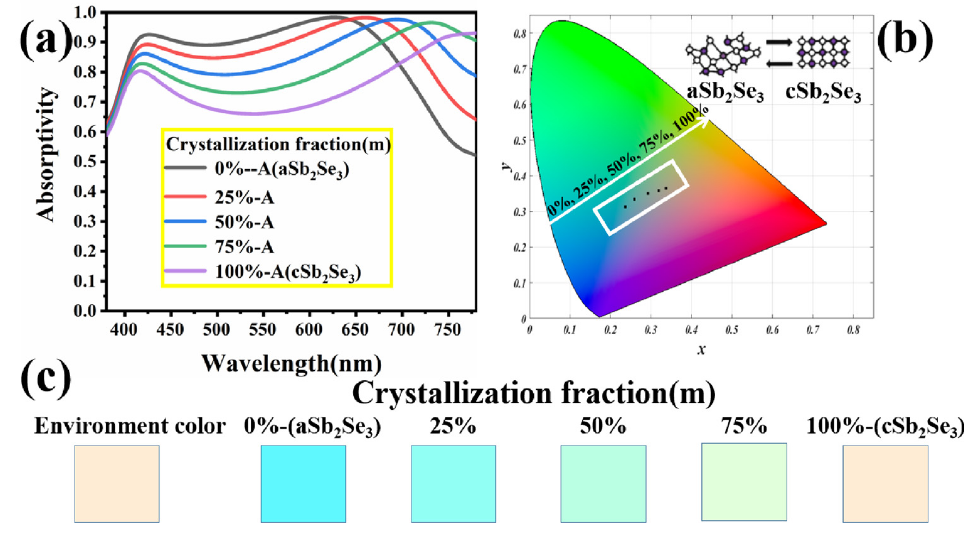
Figure 5. ( a ) Absorption spectra of different Sb 2 Se 3 crystalline fractions; ( b ) coordinates of different Sb 2 Se 3 crystalline fractions on the chromaticity diagram; ( c ) colors corresponding to different Sb 2 Se 3 crystalline fractions.